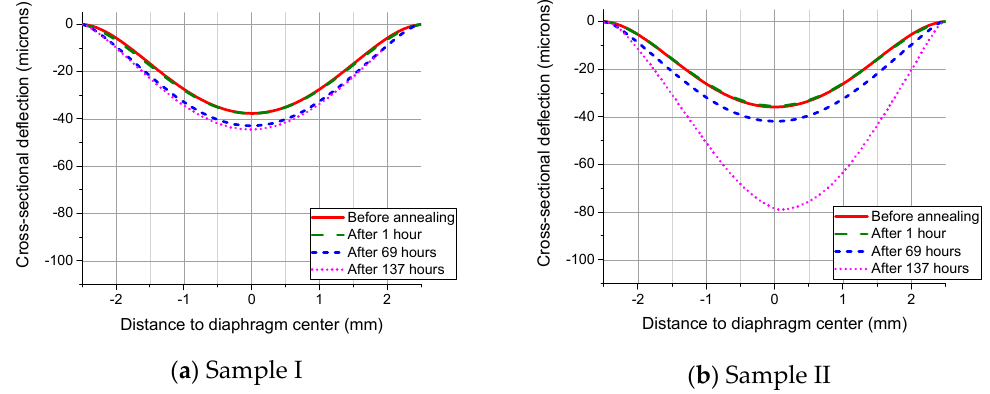
Figure 7. Surface profiles of SCS diaphragm cross-sections with a radius of 2.5 mm measured after the annealing processes at 600 °C, showing a different behavior. Table 4. The averaged maximum deflections (µm) with respect to the diaphragm radius at 800 °C